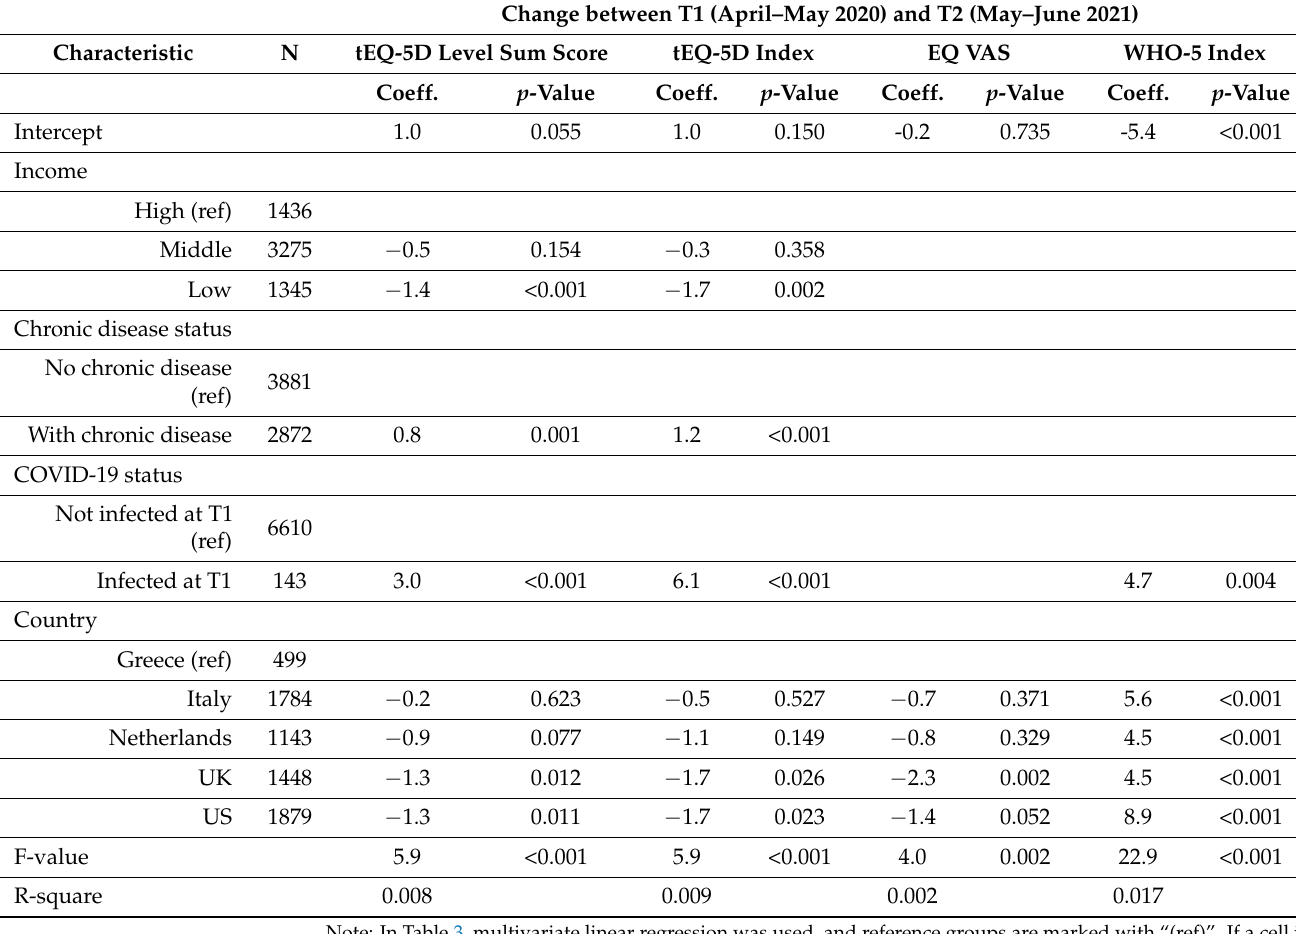
Table 3. Multivariate analyses of respondent characteristics and the change in EQ-5D-5L transformed